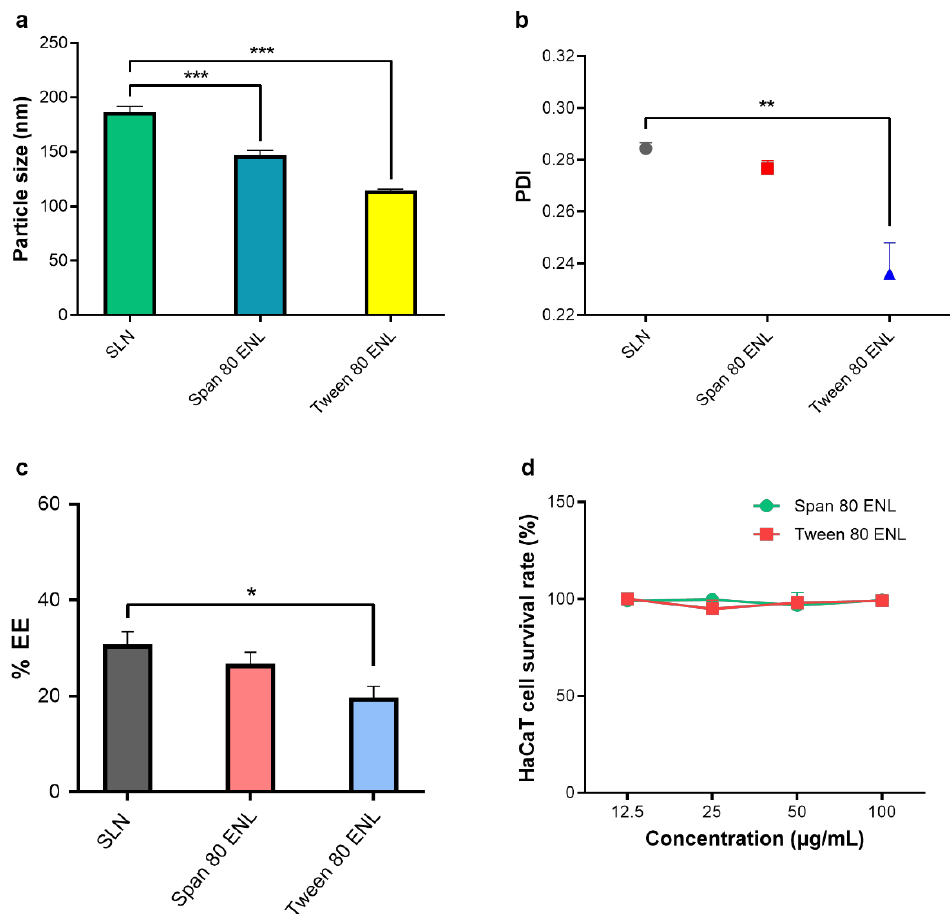
Figure 3. Formulation characteristics. ( a ) Sizes of LidH-loaded liposomes. ( b ) PDIs of LidH-loaded liposomes. ( c ) EEs of LidH-loaded liposomes. Data are shown as mean ± SD, n = 3. *, **, and *** indicate statistical significance at p < 0.05, p < 0.01, and p < 0.001 using one-way ANOVA with Bonferroni’s post-hoc test. ( d ) Cell survival rates of HaCaT cells cultured with 12.5, 25, 50, and 100 μg/mL ENL. Cell survival rates were measured as an index of cytotoxicity. Data are shown as mean ± SD, n = 3. Abbreviations: SLN, solid lipid nanoparticle; EE, encapsulation efficiency; ENL, elastic nano-liposome; LidH, lidocaine hydrochloride; PDI, polydispersity index.